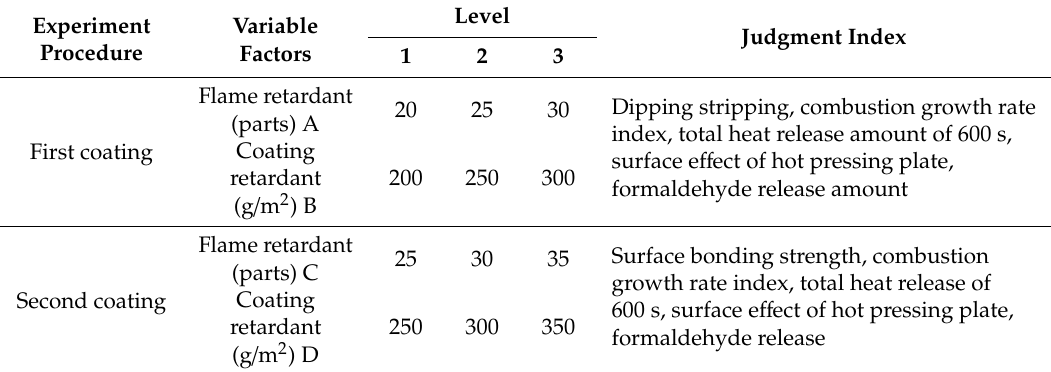
Table 1. Testing factors of the new design adhesive mixed with flame retardant